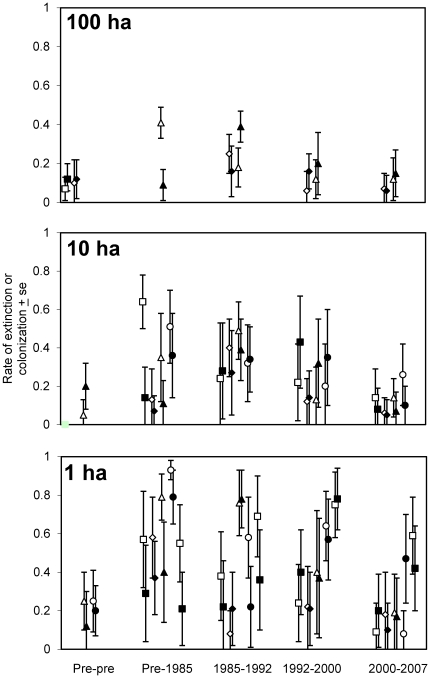
Extinction and colonization parameter estimates (± se).Each set of pairs of points of the same shape refers to an individual fragment, with the open symbol representing extinction and the filled symbol representing colonization for that interval. The 100-ha sample includes a preisolation-preisolation sample from a 100-ha plot in continuous forest sampled in 1992 and 2000 (squares). The 100-ha figure does not include a sample from preisolation – 1985 for plot 2303 (diamonds), which was not isolated until 1990.